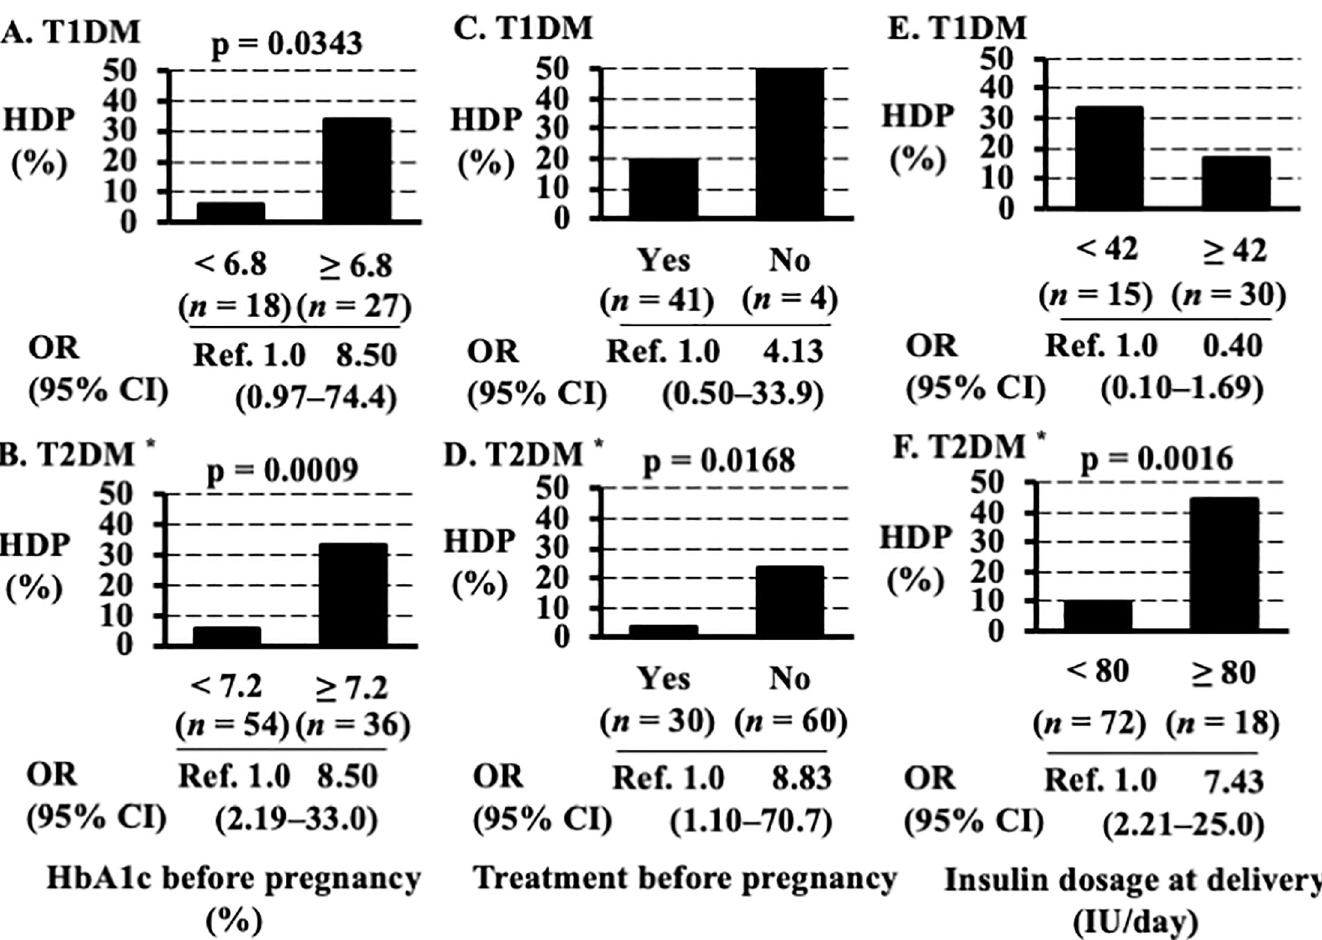
Fig 2. Differences in the incidence of HDP among women with HbA1c values above or below cutoffs during first trimester and between women who did or did not receive therapy for diabetes mellitus before pregnancy and at delivery. (A) Among women with T1DM, the differences in incidence of HDP among women with HbA1c values above or below the cutoff during the first trimester. (B) Among women with T2DM without CH, the differences in incidence of HDP among women with HbA1c values above or below the cutoff during the first trimester. (C) Among women with T1DM, the differences in incidence of HDP among women who did or did not receive therapy for diabetes mellitus before pregnancy. (D) Among women with T2DM without CH, the differences in incidence of HDP among women who did or did not receive therapy for diabetes mellitus before pregnancy. (E) Among women with T1DM, the differences in incidence of HDP among women with insulin dosage at delivery for diabetes mellitus above or below the cutoff. (F) Among women with T2DM without CH, the differences in the incidence of HDP among women with insulin dosage at delivery for diabetes mellitus above or below the cutoff. Abbreviations: HDP; hypertension disorder of pregnancy, HbA1c; hemoglobin A1c, T1DM, type 1 diabetes mellitus; T2DM without CH, type 2 diabetes mellitus but without chronic hypertension; CI, confidence interval; OR, odds ratio; Ref, reference.